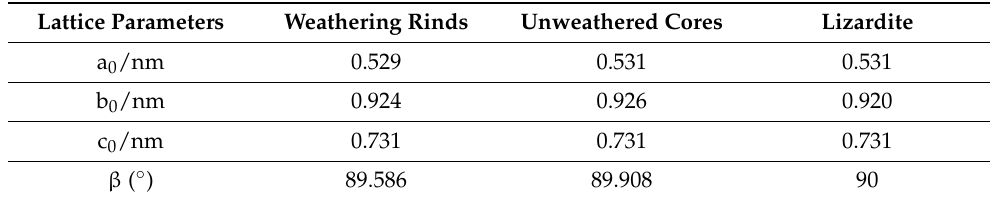
Table 2. Lattice parameters of weathering rinds and unweathered